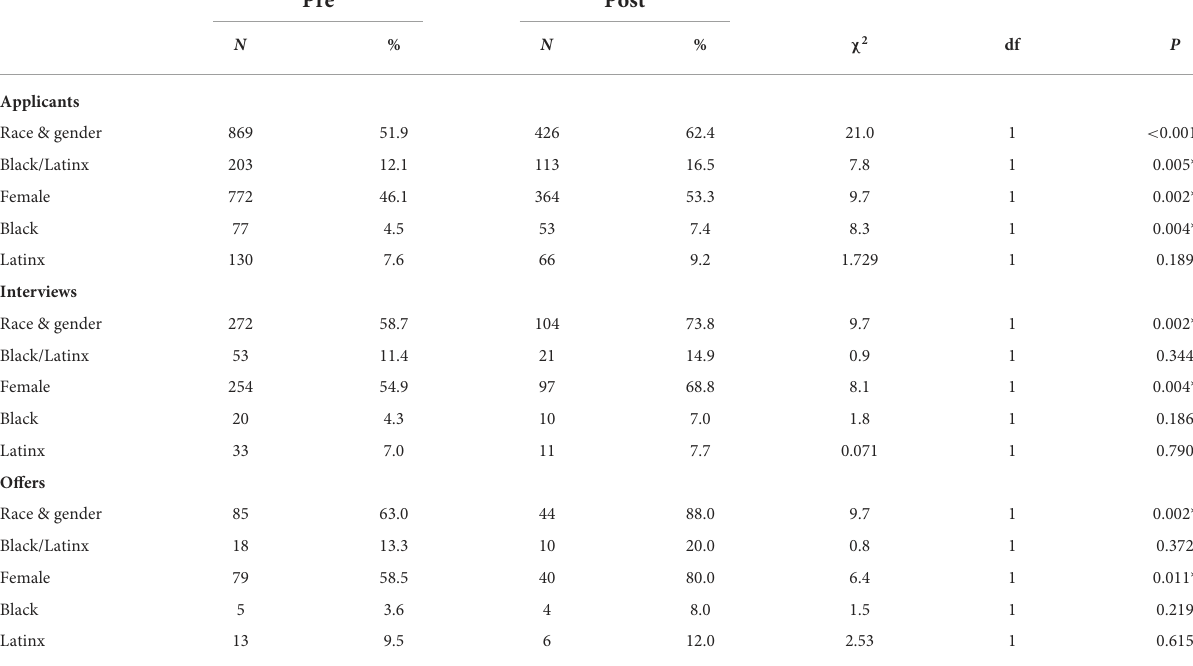
TABLE 3 Chi-square analyses of diversity of faculty job applicants, applicants offered interviews, and those offered the job, before and after implementation of faculty search committee